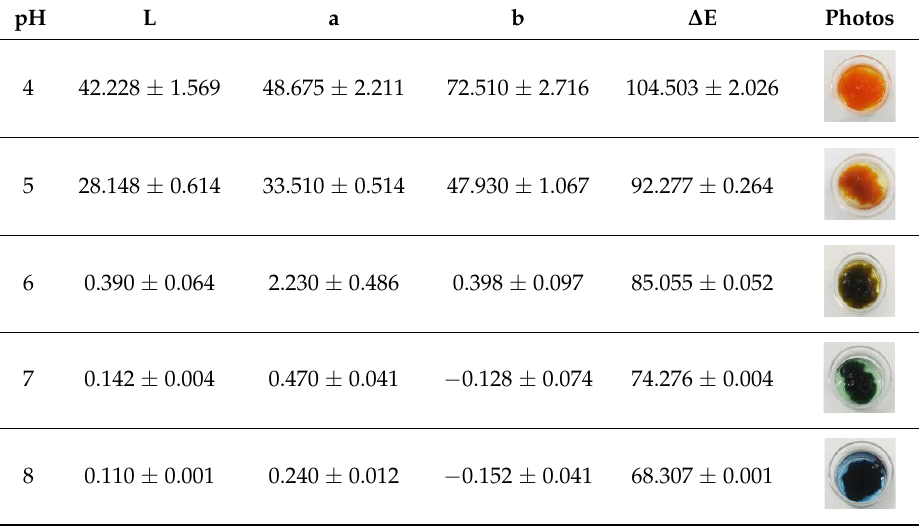
Table 3. pH response of IS-pH-SCF under pH from 4 to 8.